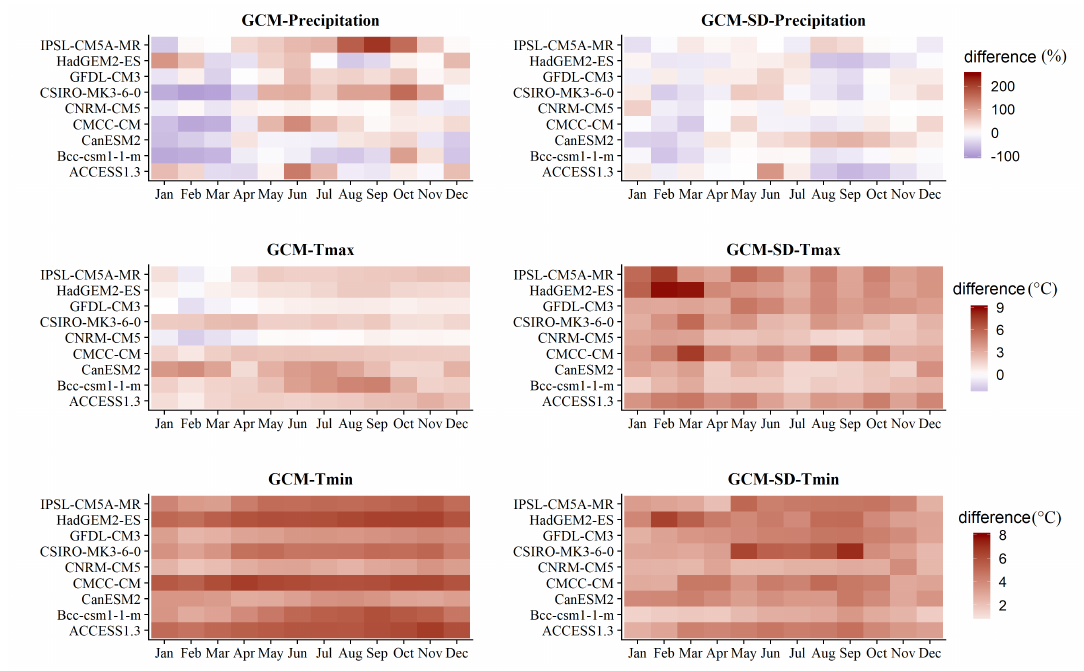
Figure 9. Relative Changes in mean monthly precipitation (first row,in %), mean monthly maximum temperature (second row; delta change), mean monthly minimum temperature (third row; delta change) for the 2071–2100 period under RCP8.5 scenario relative to the observed values during 1985–2014 at station S24. Left column denotes the original GCM values, right column represents the spatially and temporally downscaled GCM